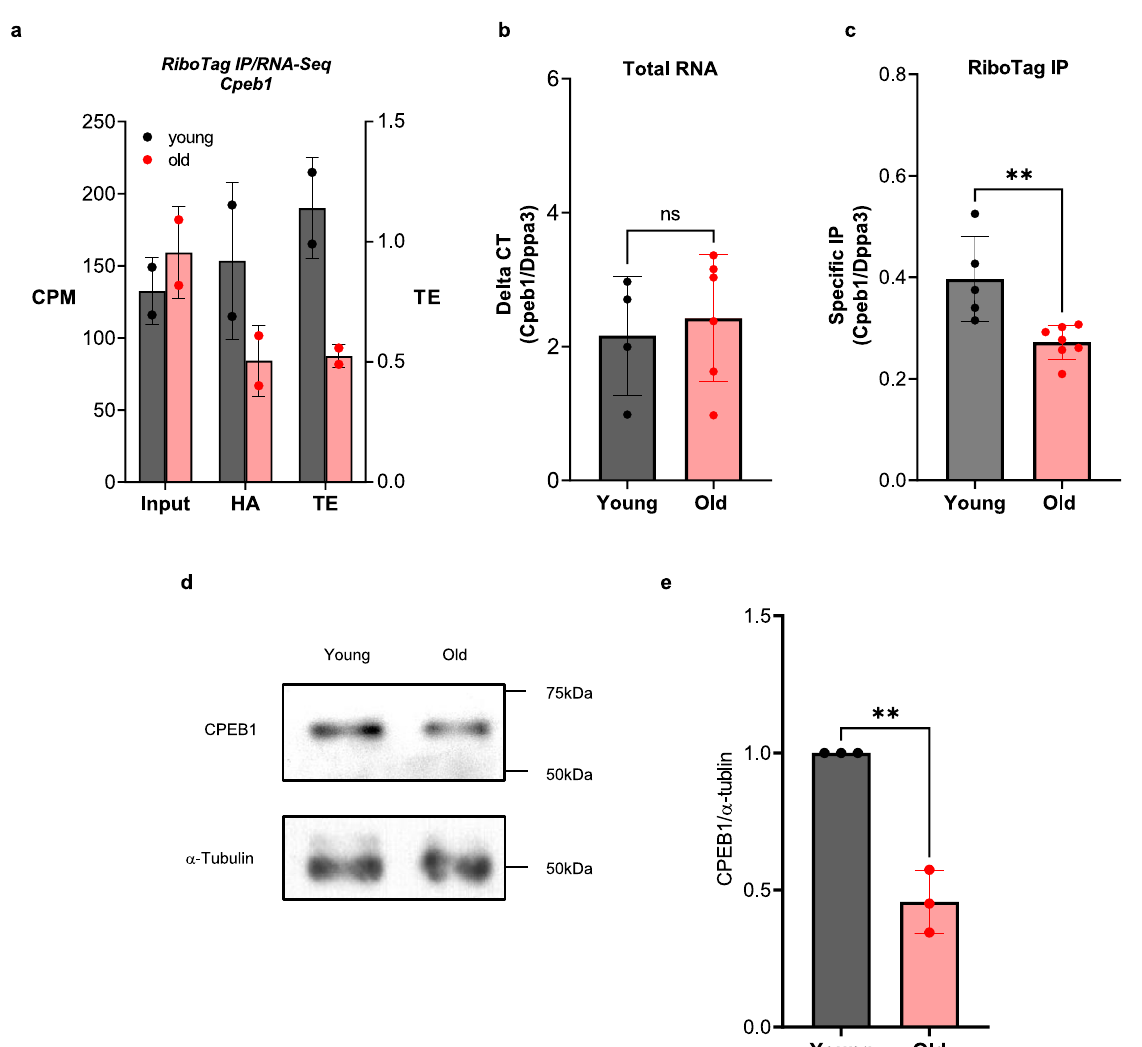
Fig. 4 | Translation of CPEB1 mRNA and protein is decreased in old oocytes. a MII oocytes were collected from young and old RiboTag F/F ;Zp3-Cre mice and RiboTag IP followed by RNA-Seq was performed as described in “ Methods ” . The average CPM fortotaltranscripts(Input)andribosomeloading oftranscripts(HA) arereported.TEwascalculatedastheratiobetweenribosome-associatedandtotal mRNA CPM. Two independent biological samples were used in this analysis. b , c Ovaries were collected from young and old RiboTag F/F ;Zp3-Cre mice and RiboTagIPfollowedbyRT-qPCRwasperformedasdescribedin “ Methods ” . Dppa3 was used as a reference gene. Input data ( b ) and ribosome-loading mRNA ( c ) are reported. b n =4(young),6(old)biologicallyindependentsamplesareused. c n =5 (young), 7 (old) biologically independent samples are used. RT-qPCR reactions